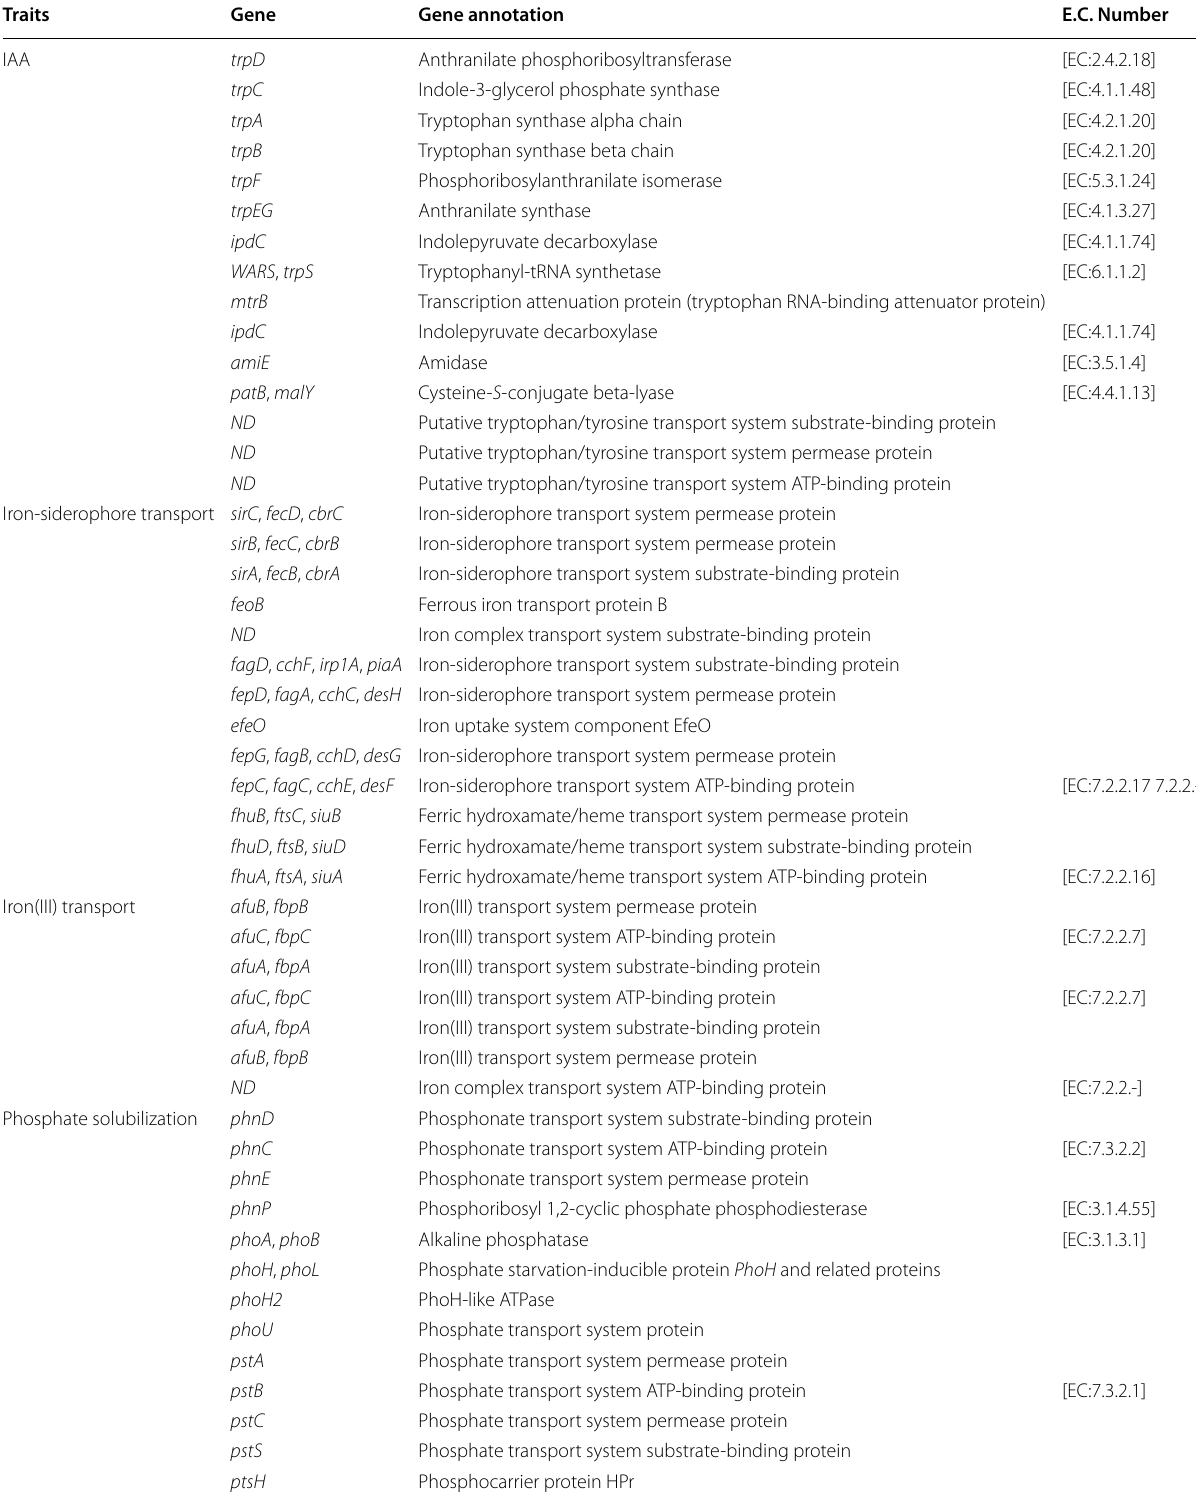
Table 2 Genes involved in plant growth-promoting traits based on BlastKOALA and RastSEED